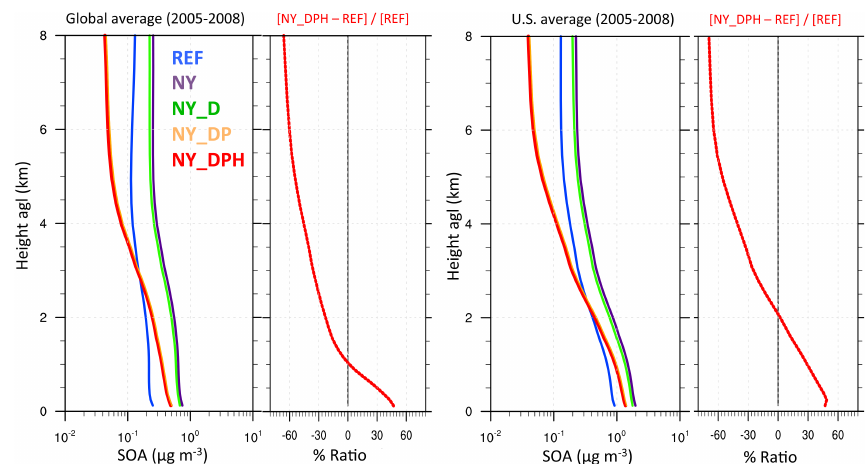
Figure 2. Vertical profiles of average SOA concentrations (at ambient temperature and pressure) integrated globally and regionally over the continental USA between 2005 and 2008. GEOS-Chem predictions from five simulations are shown including REF (blue), NY (purple), NY_D (green), NY_DP (orange) and NY_DPH (red). The ratios between SOA predictions by the NY_DPH and REF runs are also shown for each